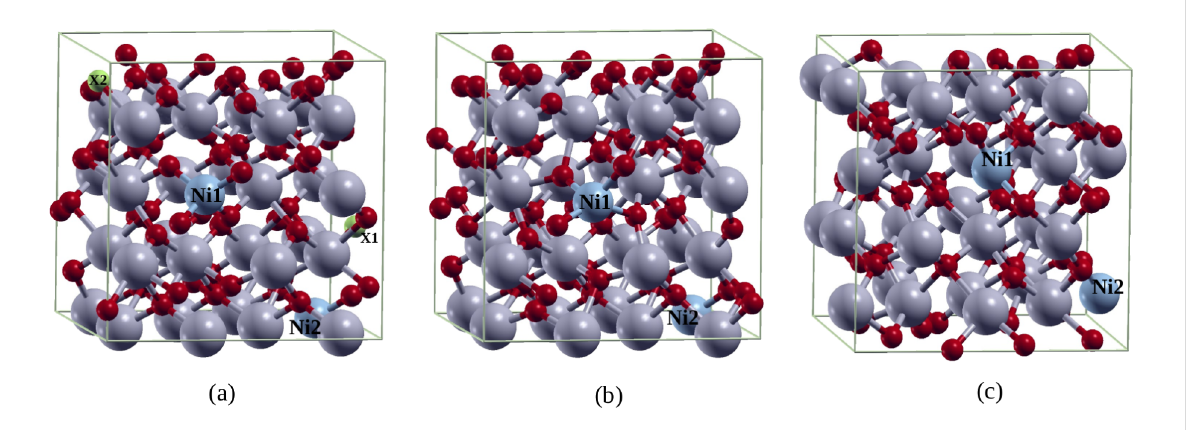
Figure 1: (a) Zirconia containing two Ni atoms substituting Zr atoms without O vacancies, that is, structure S 0 . (b) Structure S 1 , which is S 0 containing a single O vacancy wherein the oxygen atom (green sphere) marked X1 in (a) has been removed. (c) Structure S 2 , which is S 0 containing a double O vacancy wherein the O atoms (green spheres) marked X1 and X2 have been